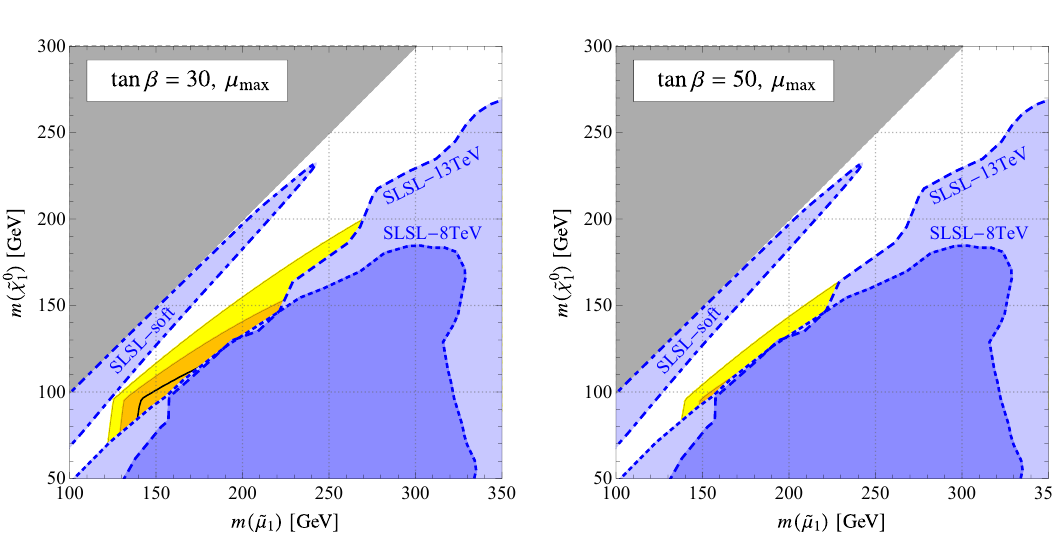
Figure 2. The summary of the bino-dominated SUSY scenario for the muon g − 2 anomaly. The universal slepton mass with m tan β = 5 , 10 , 30 and 50 . The µ parameter is maximized ( µ described in the text. The muon g − 2 anomaly can be explained at the 1 σ ( 2 σ ) level in the orange- filled (yellow-filled) regions. Below the black line in each figure, a SUSY ∆ a in eq. (1.5) for the maximized µ parameter. In the gray-filled regions, µ The blue-filled regions are excluded by the LHC slepton searches [50, 52, 73,